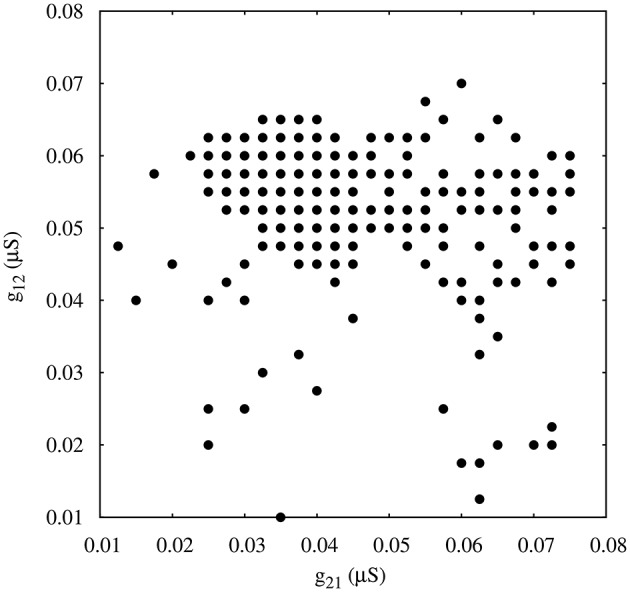
Map of conductances g12 and g21 of the circuits with gap-junction induced asymmetry that lead to regularization of the spiking-bursting activity where the incremental step for both g12 and g21 is 0.0025 μS. Black circles represent values that lead to regular activity (Cv < 5%). Parameters: k1 = 0.6 ms−1, k2 = 0.27 ms−1, g23,32gj = 0.0045 μ S.